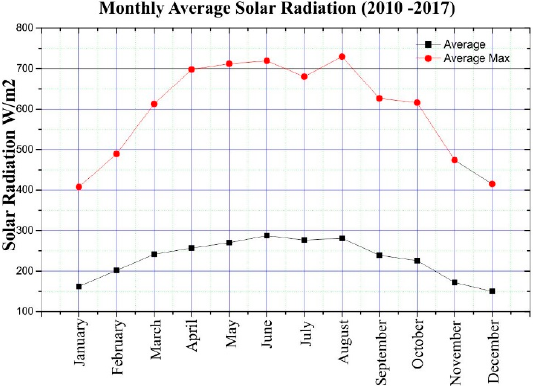
Figure 3. Statistical data of solar radiation in Matehuala SLP, Mexico (2010–2017).